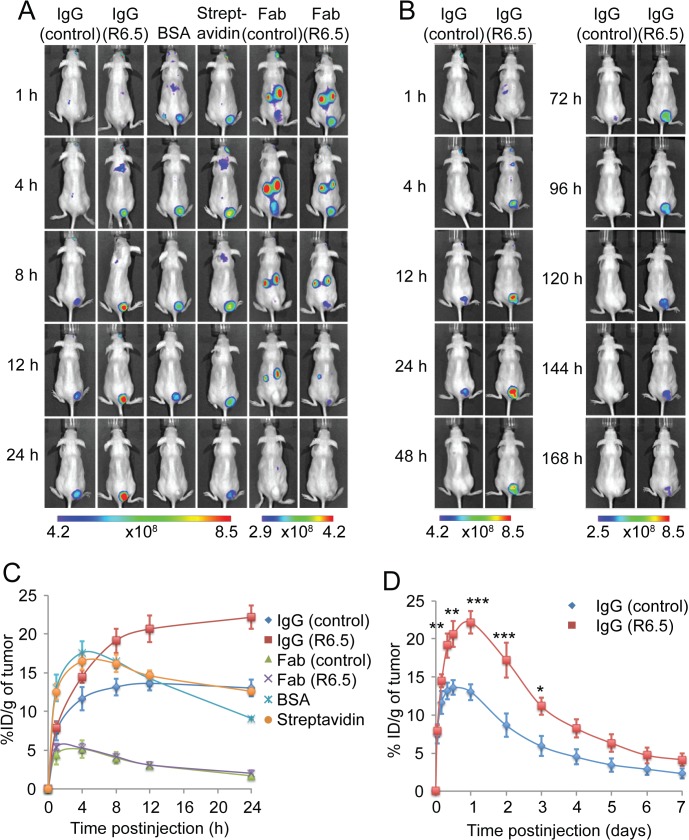
Real-time whole body imaging of biomolecules in mice xenografted with HeLa tumors.(A, B) Representative time-course images of merged fluorescence and bright fields are shown for HeLa-implanted SCID mice after intravenous administration of the fluorescence labeled imaging agents. Note that different color scales, representing fluorescence intensity in arbitrary units, are used for optimal signal-to-noise ratios. (C, D) Quantification of tumor uptake of each imaging agents was obtained with Living Image software. Error bars are SEMs. Two-way ANOVA followed by Bonferroni post-hoc test was used to evaluate statistical significance of responses of different imaging agents at different time points (S2 Table). Significant differences are indicated with *p < 0.05, **p < 0.01, ***p < 0.001 for R6.5 and control IgG (n = 3 for all except n = 6 for R6.5 and control IgGs at 1, 4, 12 and 24 h postinjection).